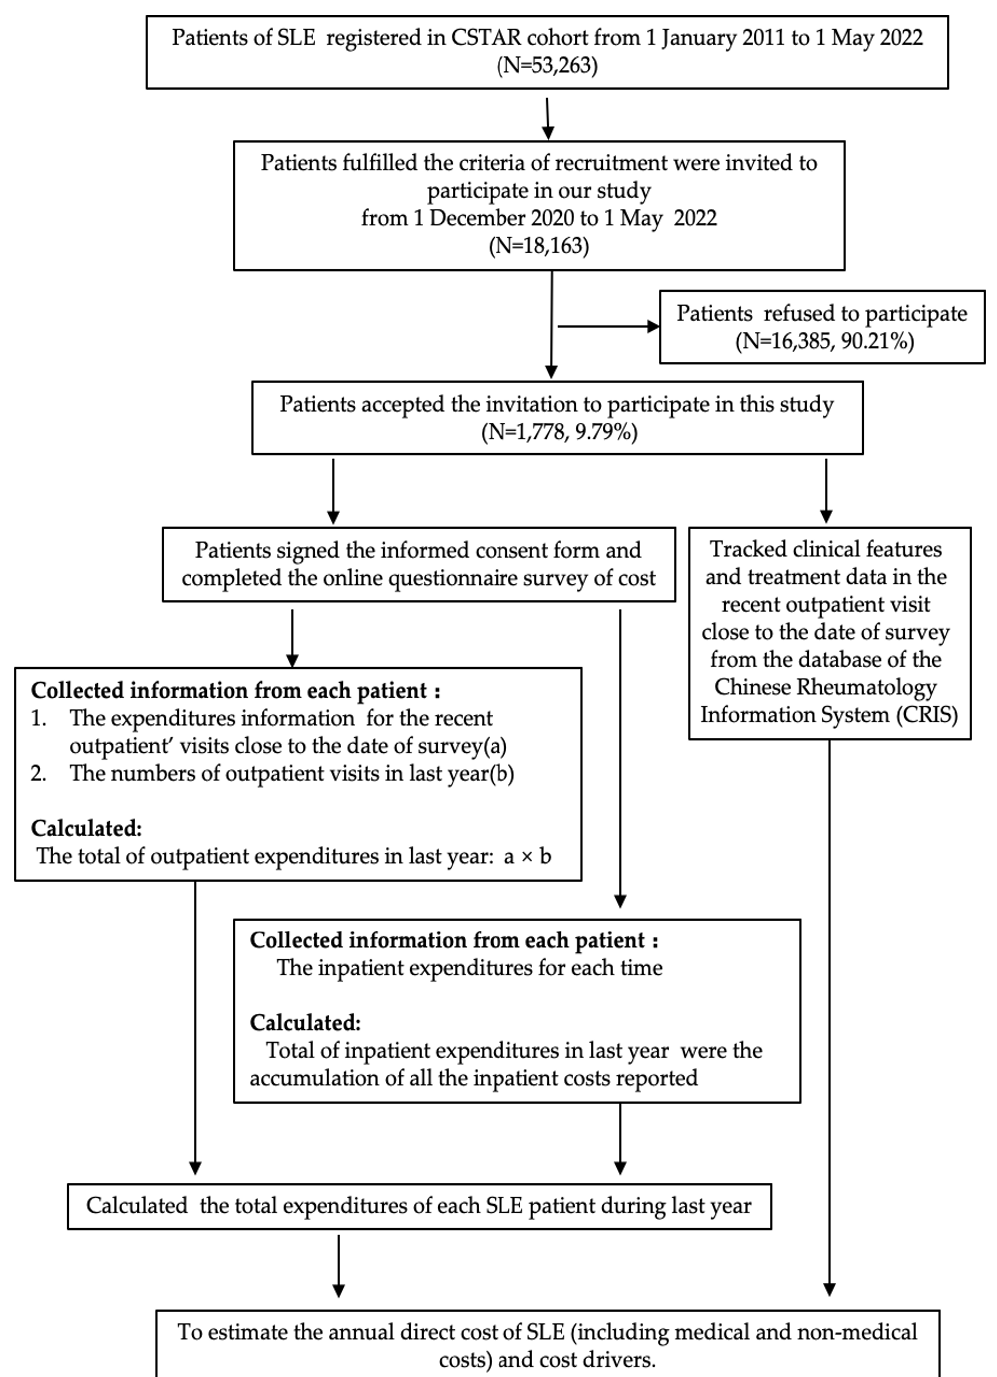
Figure 1. A flow chart of study participants and its design.